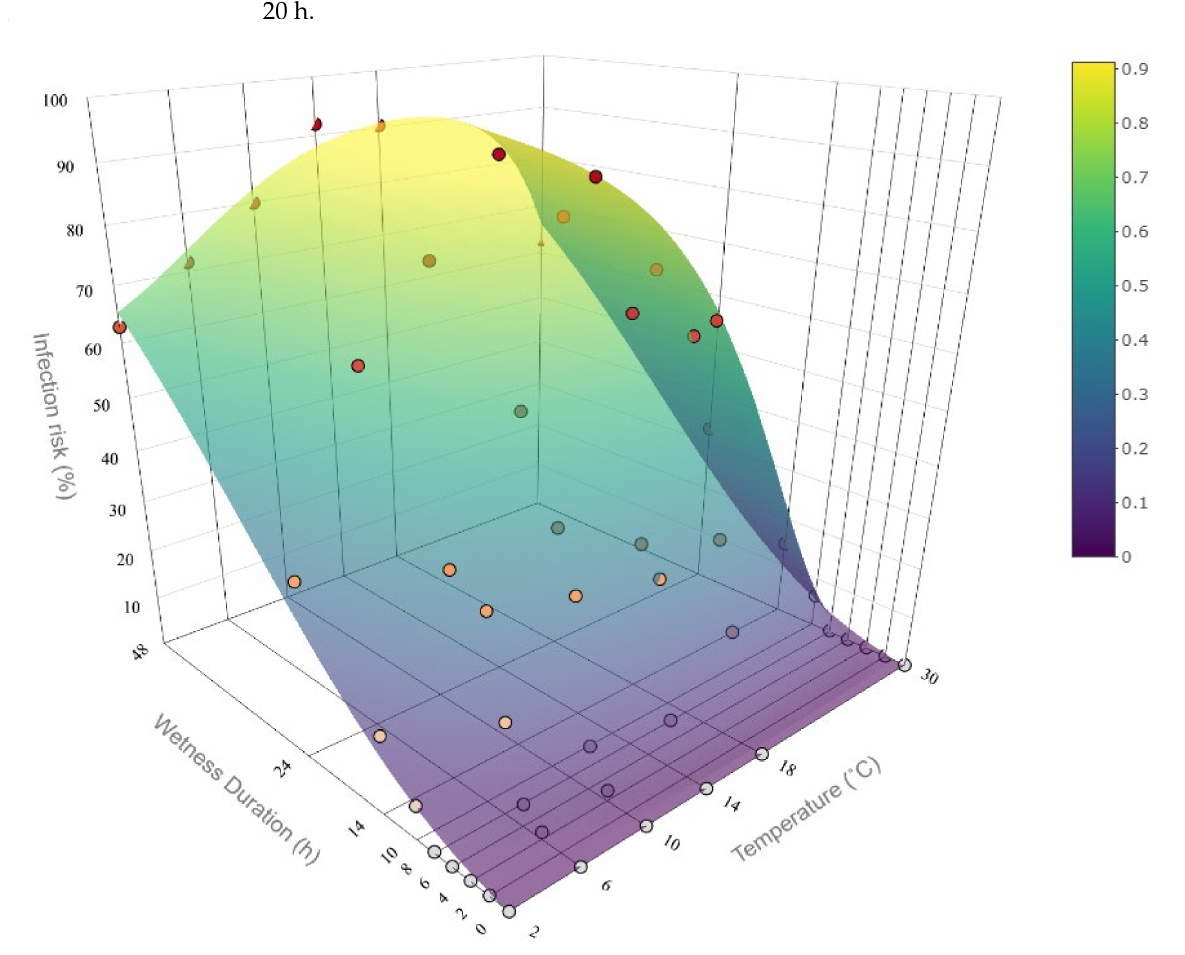
Figure 6. Surface plot representing the implementation of the Monilinia vaccinii-corymbosi apothecial presence model in northwestern Washington blueberry production systems fitted to experimental data by Hildebrandt and Braun [4] (represented with dots). The infection risk for the temperature at 30 ◦ C was not present in the data set and was extrapolated. The surface represents the infection risk (%) modeled as a function of wetness duration and